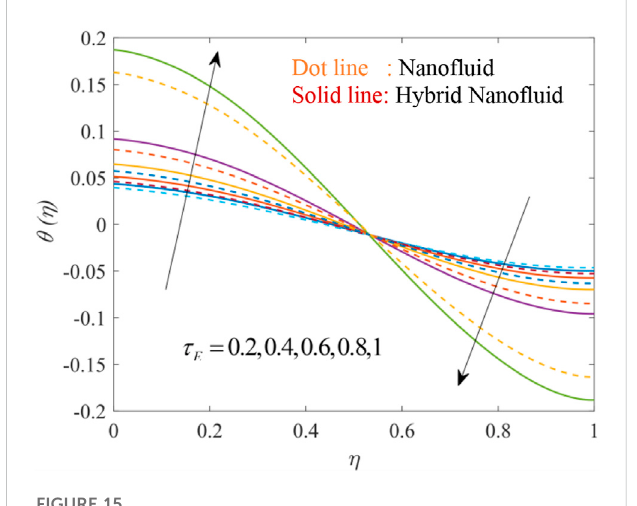
FIGURE 17 Effect of heat source/sink parameter A* and B* on θ ( η ) .